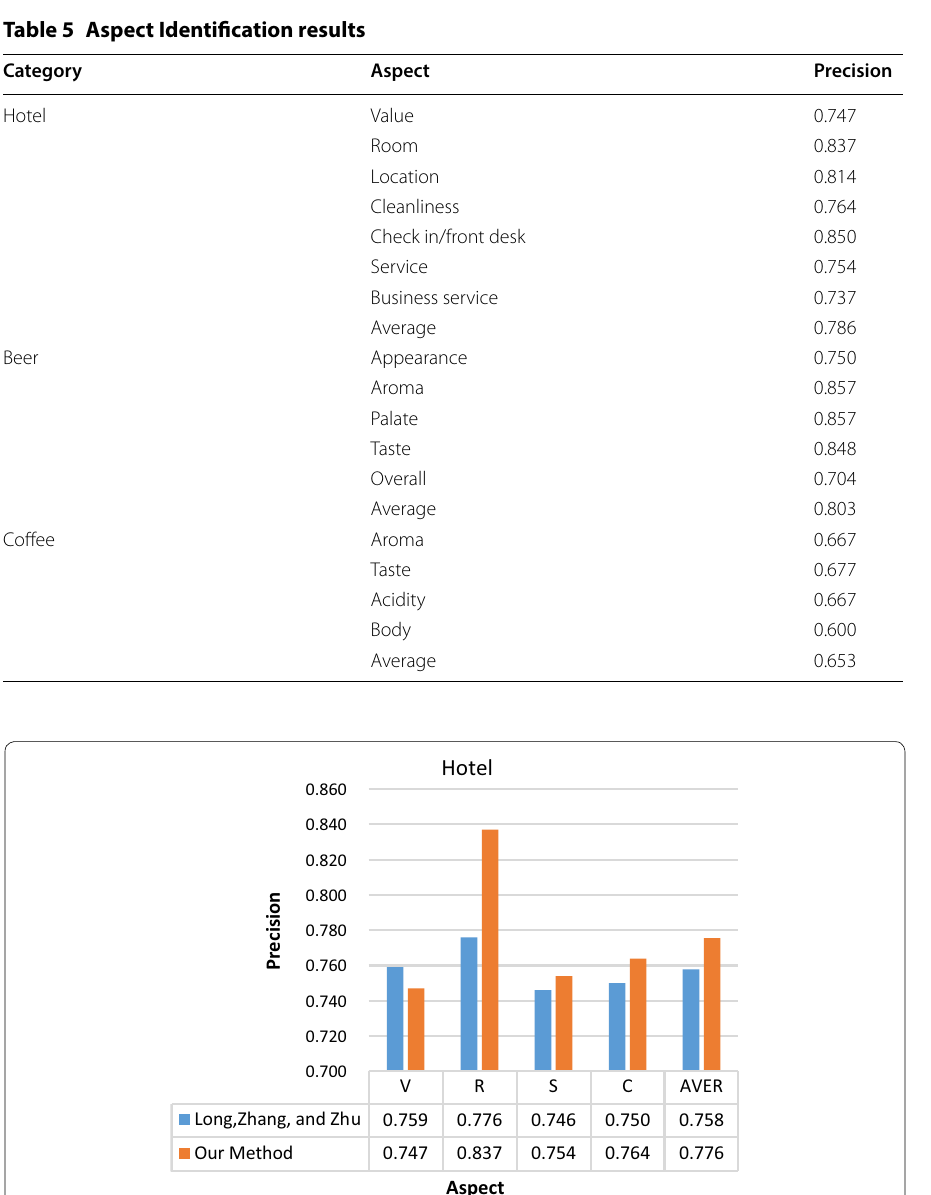
Fig. 4 The results of our method and Long et al.